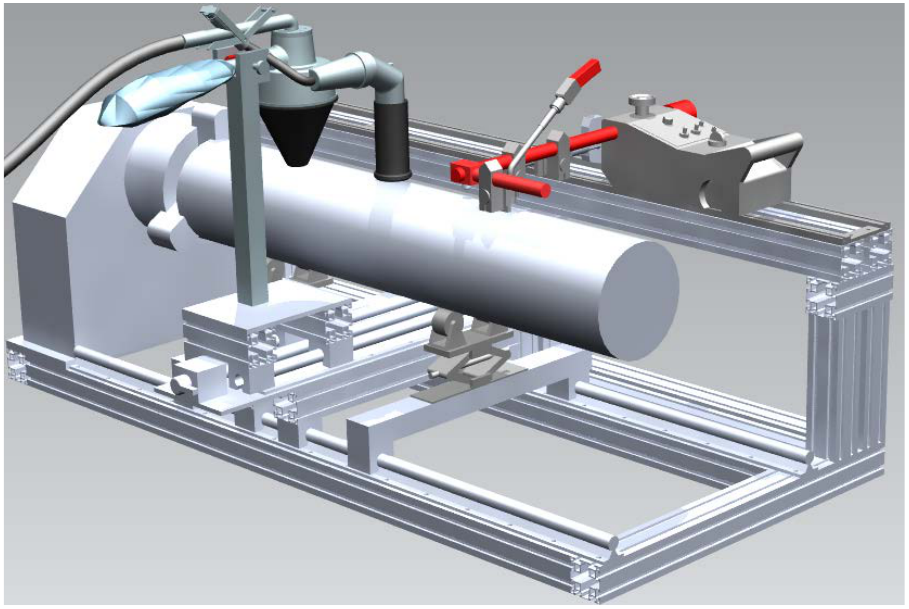
Figure 3. Designed installation for restoration of a long rods.